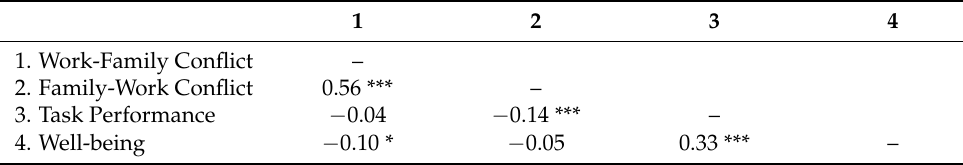
Table 3. Association between the variables under study.